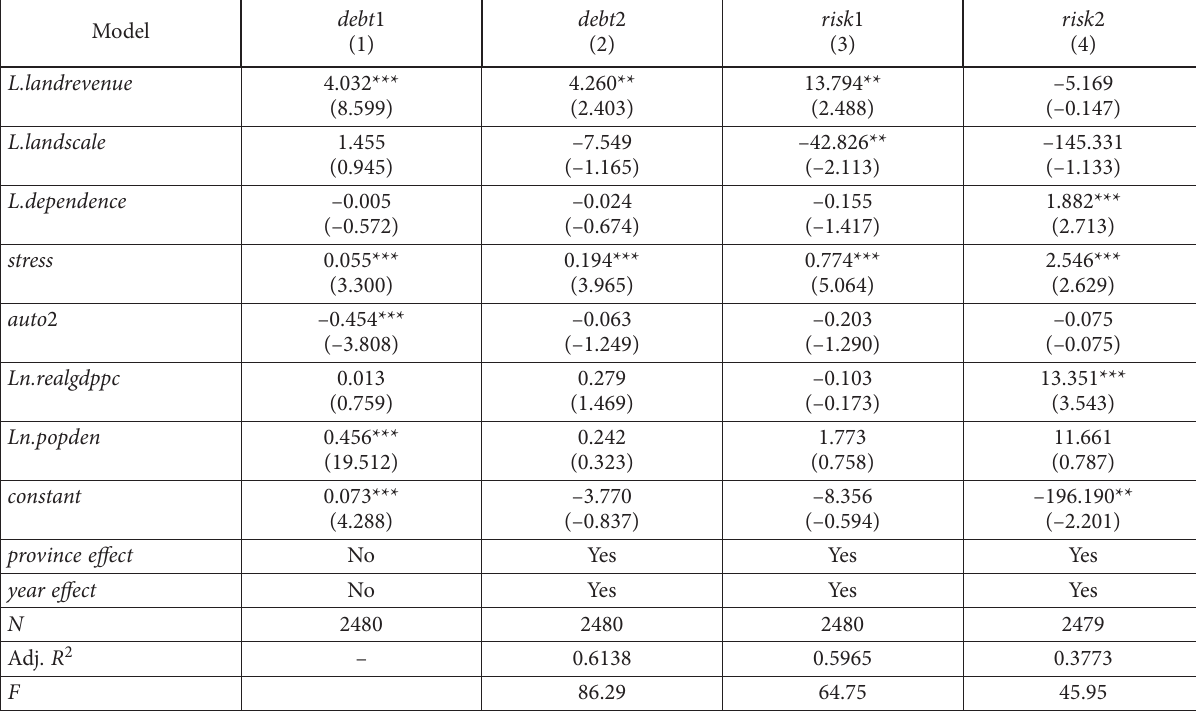
Table 3. Model regression results on the impact of debt and